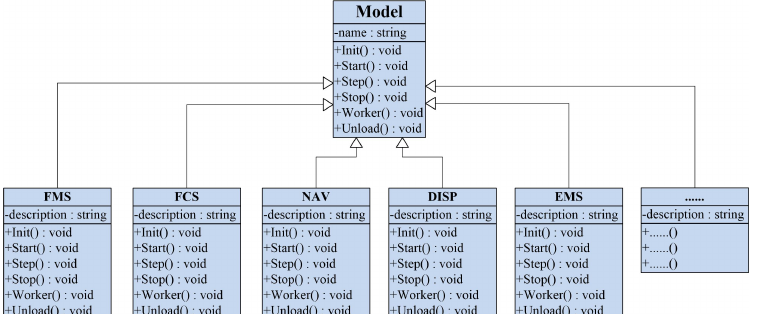
Figure 3. Class diagram of component models.